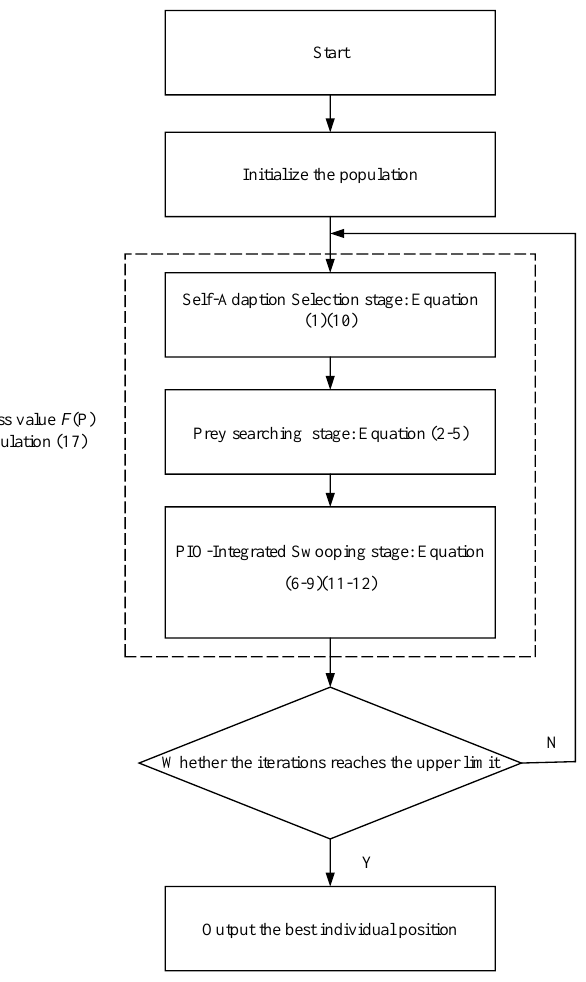
Figure 6. Final SAHBES structure block